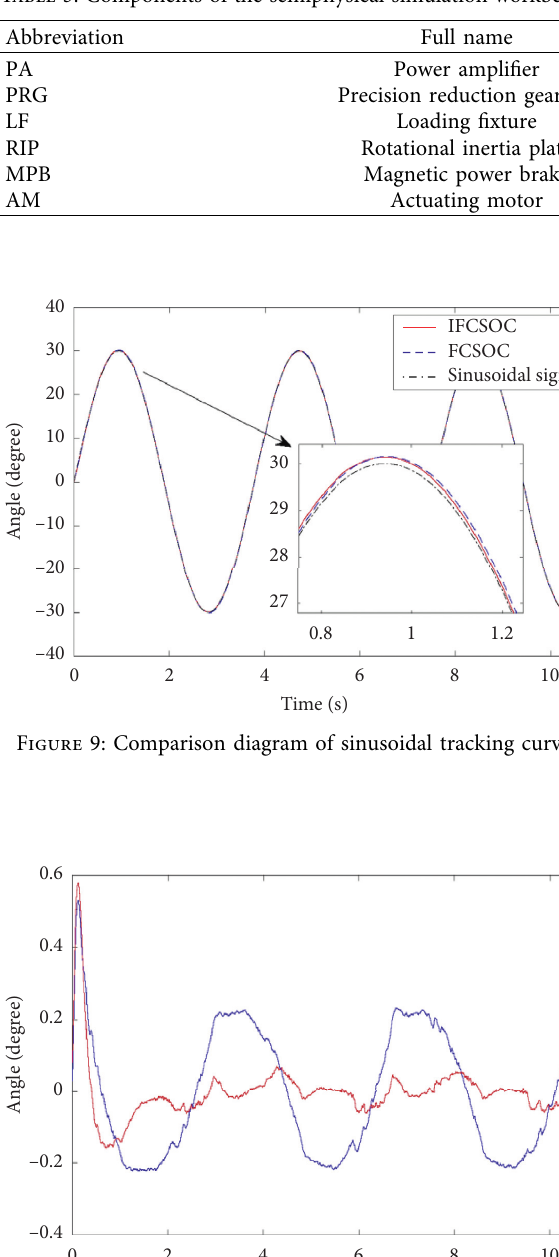
Table 3: Components of the semiphysical simulation workbench.